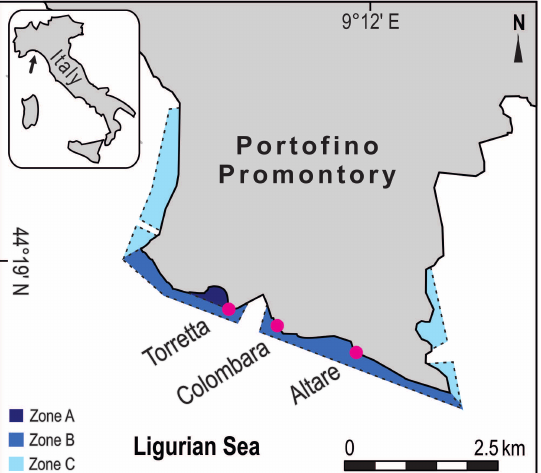
Figure 1. Map of the Portofino Marine Protected Area (Ligurian Sea, NW Mediterranean) with the three sites surveyed (Altare, Colombara, and Torretta) represented by hot pink circles. Geographic coordinates in WGS84.